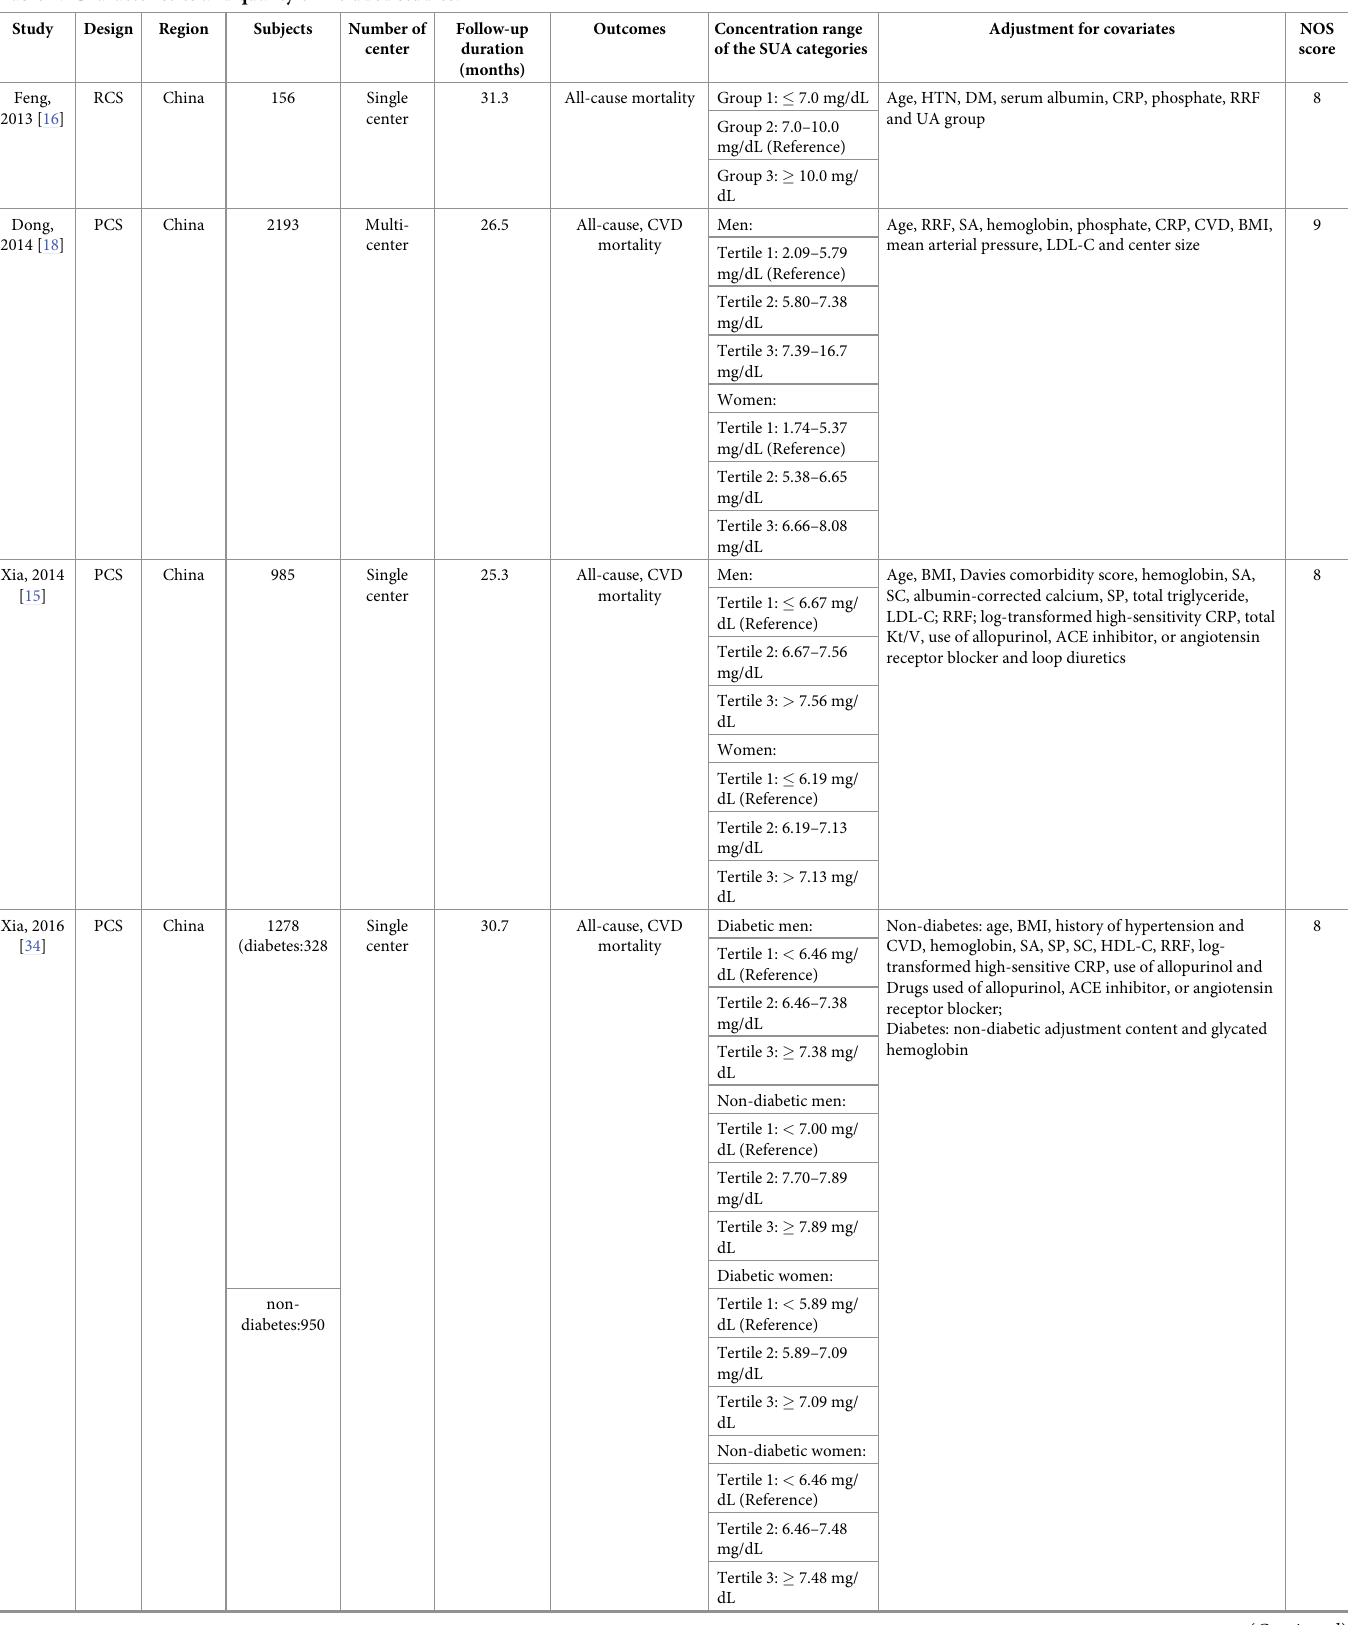
Table 1. Characteristics and quality of included